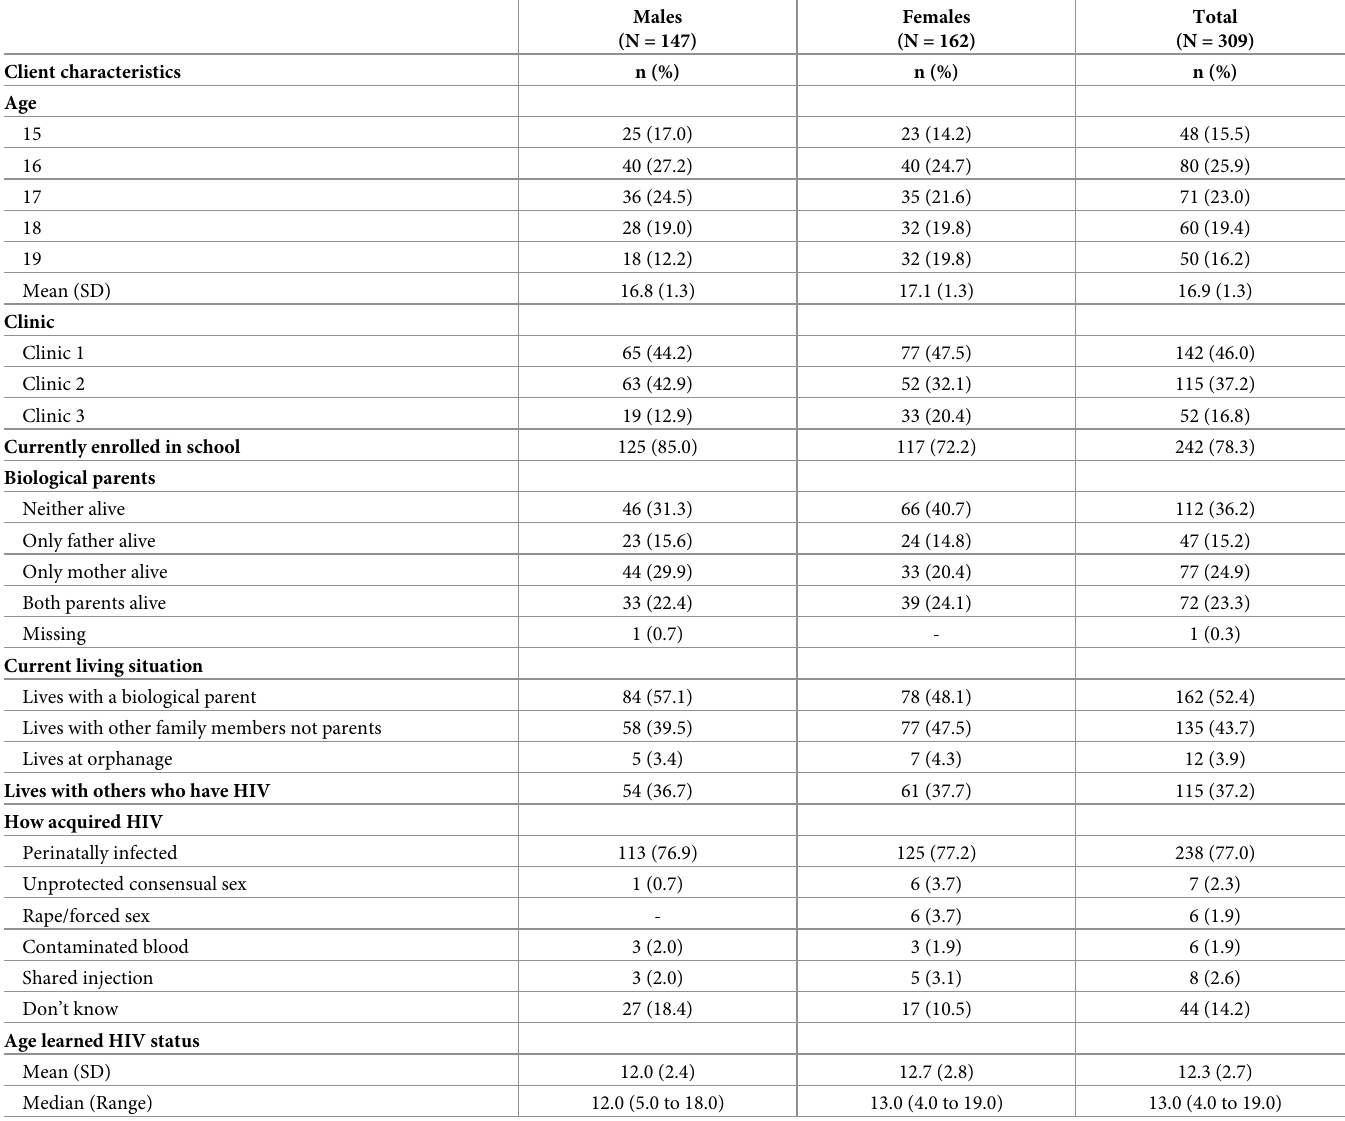
Table 2. Demographic characteristics of study participants stratified by sex.